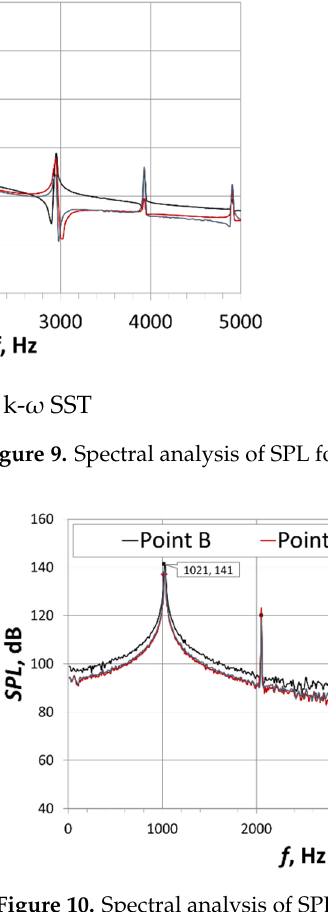
Figure 11. Acoustic pressure fluctuations for velocity in the main channel equal to 50 m/s—CFD.